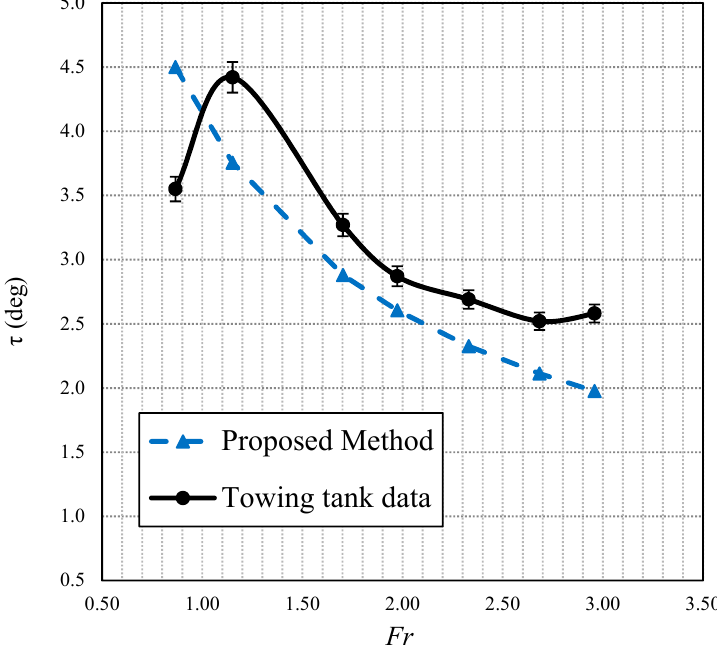
Figure 10. The dynamic trim angle: 2D + T method vs. experimental results.